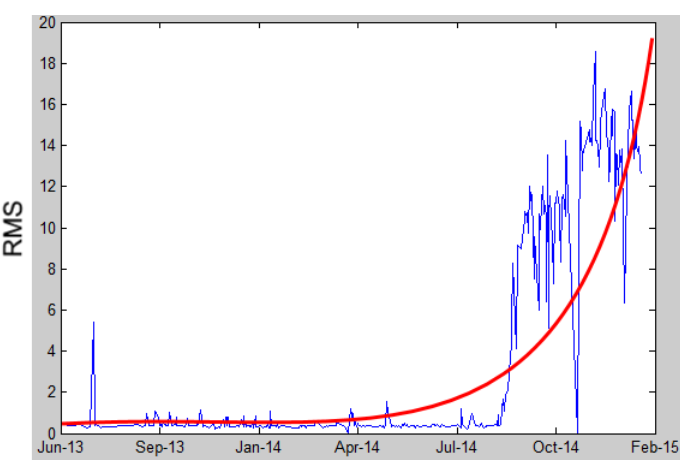
Figure 5. Root mean square level development with time—the red curve shows the trend.